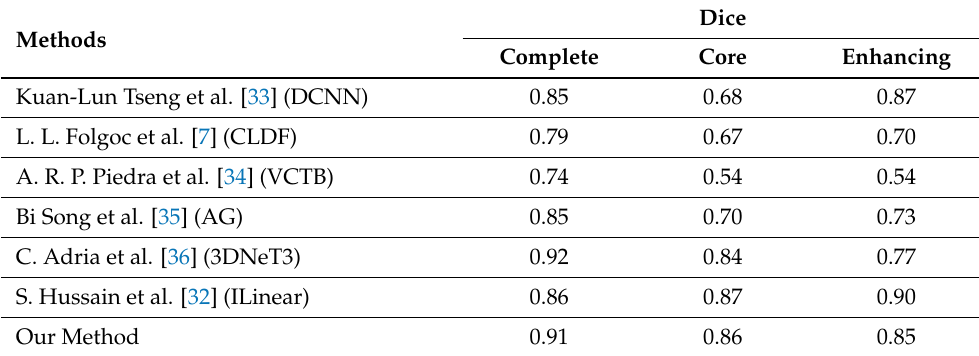
Table 4. On the BRATS 2015 Challenge dataset, comparison with different